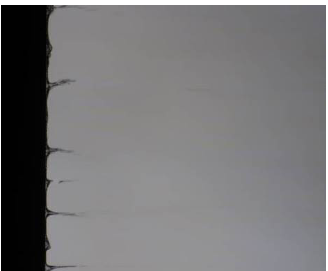
Fig. 5. Water curtain formed by the aqueous solution of the detergent.